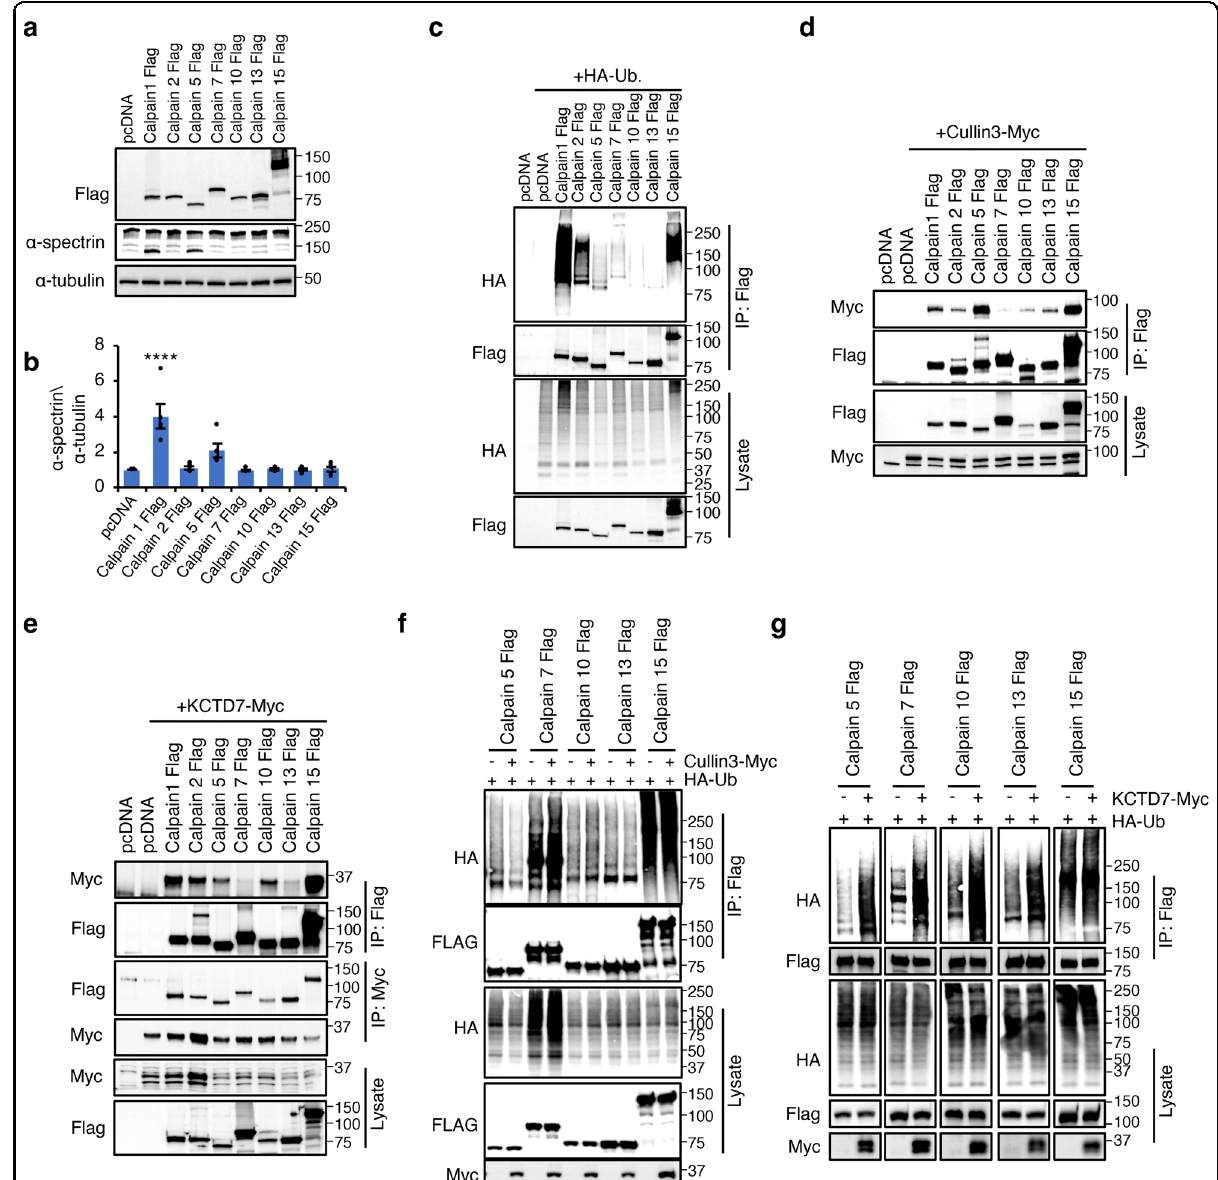
Fig. 5 Ubiquitination-mediated regulation is common in calpain family. a , b Ubiquitous expressing calpains were expressed in HEK293 cells and α -spectrin cleavage was evaluated by immunoblotting, n = 3. c In vivo ubiquitination assay for calpains performed by coexpressing with HA-Ub in HEK293 cells for 36 h. d Co-IP analysis of Flag-tagged calpains and myc-tagged Cullin-3 in HEK293 cells. e Co-IP analysis of Flag-tagged calpains and myc-tagged KCTD7 in HEK293 cells. f In vivo ubiquitination assay in HEK293 cells for calpains performed by expressing alone or in combination with Cullin-3. g In vivo ubiquitination assay in HEK293 cells for calpains performed by expressing alone or in combination with